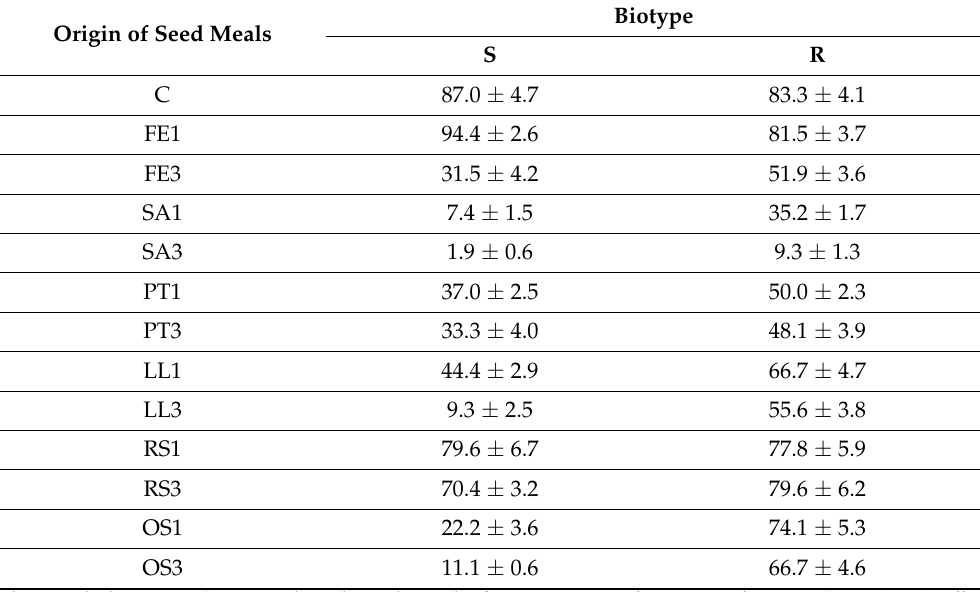
Table 3. The mean and the standard deviation emergence of herbicide-susceptible (S) and -resistant (R) biotypes of wild oat depending on the origin of seed meals and their concentration (14 days after